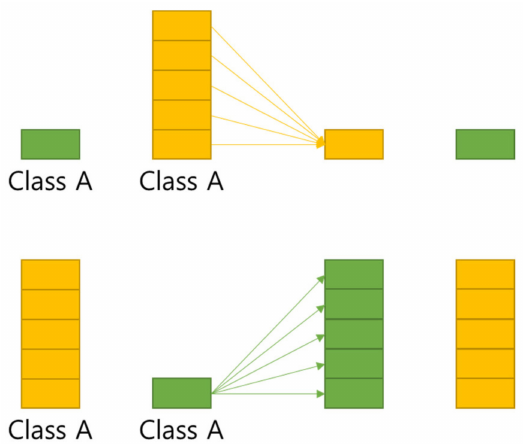
Figure 9. Undersampling and Oversampling methods.